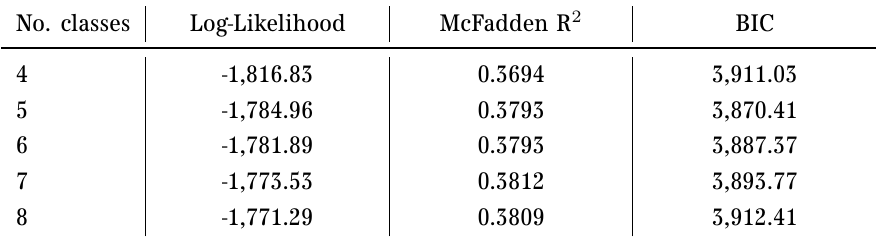
Table 5: Comparison of goodness of fit statistics for discrete shipment size choice model with 4, 5, 6, 7 and 8 latent